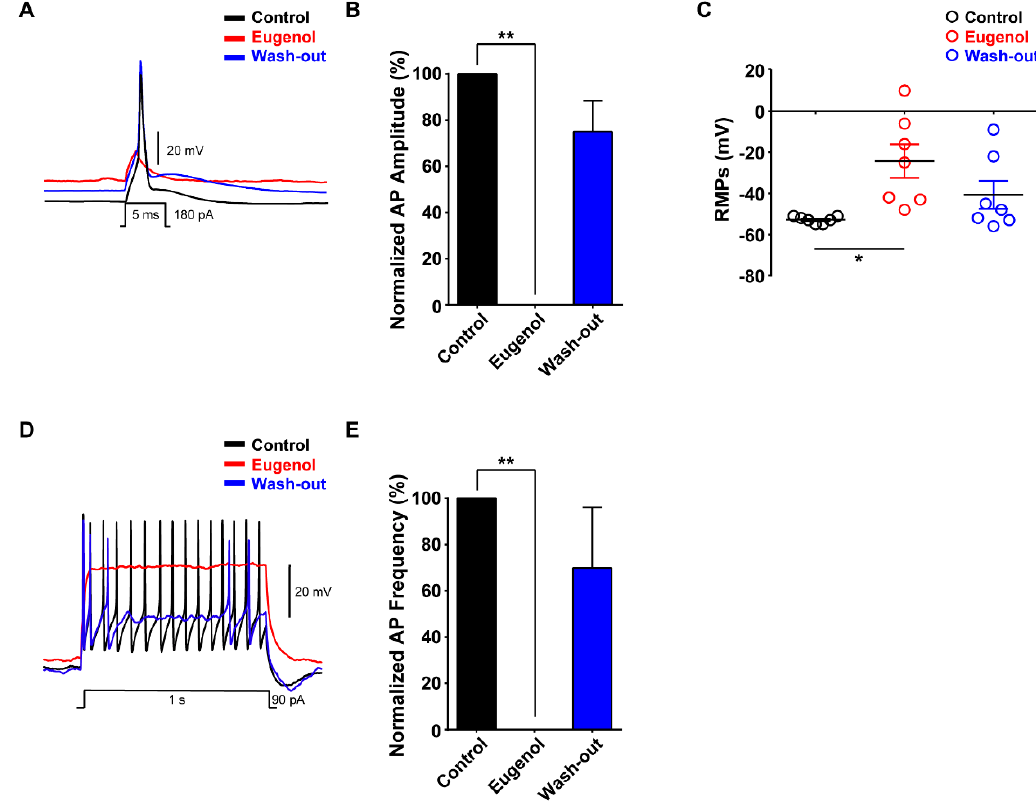
Figure 2. E ff ect of eugenol on action potentials in small-sized TG neurons. ( A ) Eugenol (2 mM) inhibited action potentials (APs) following current injection (5 ms, 180 pA) in TG neurons. Traces of single APs were observed before (control) and after treatment with eugenol. ( B ) All data were normalized to controls (black bar) ( n = 7). ( C ) Resting membrane potential (RMP) values: control, − 53 mV; after treatment with eugenol, − 24 mV; and after wash-out, − 41 mV. ( D ) Eugenol suppressed the AP frequency in TG neurons. ( E ) All data were normalized to controls (black bar) ( n = 6). * p < 0.05 versus control, ** p < 0.01 versus control. APs: action potentials, RMPs: Resting membrane potentials.